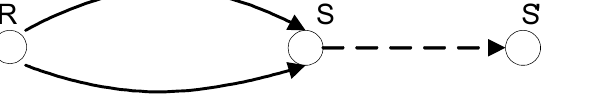
Figure 2. The Extended network